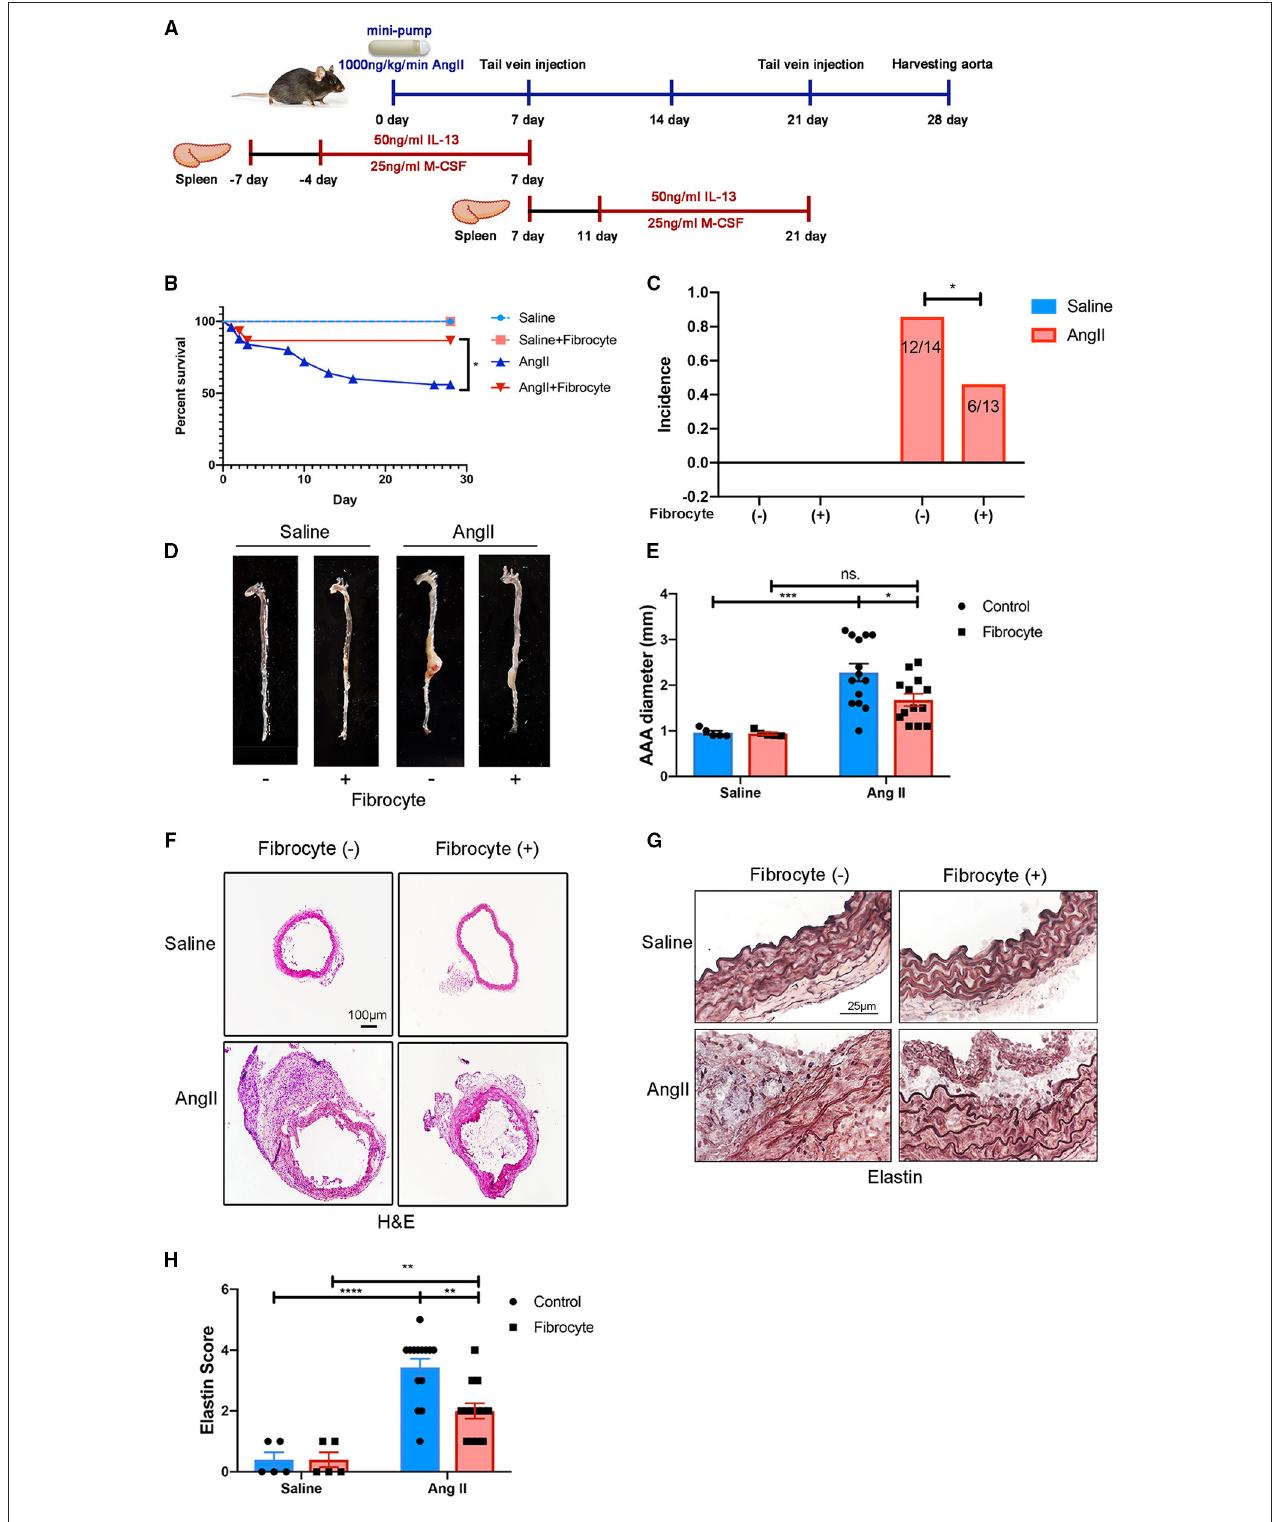
FIGURE 6 | Alleviation of Ang II-induced AAA formation by reconstitution of fibrocytes. (A) Schematic diagram of the fibrocytes reconstitution experiment. (B) Survival curves of control and Ang II-infused mice with or without fibrocytes reconstitution [Fibrocyte (–): n